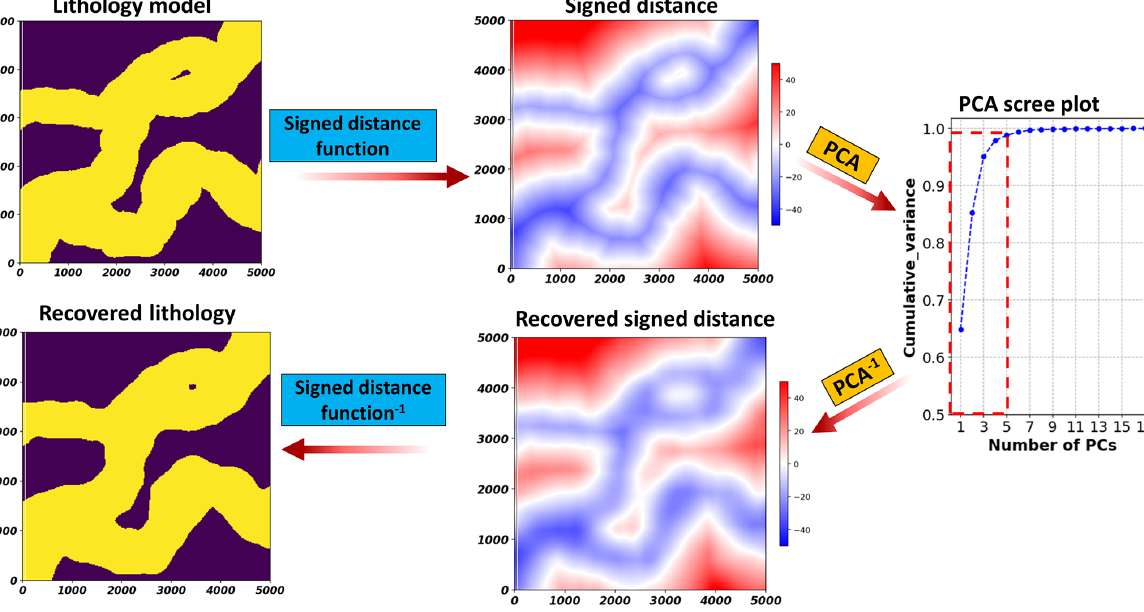
Figure 2. Example of transforming categorical lithology model to continuous signed distances for performing